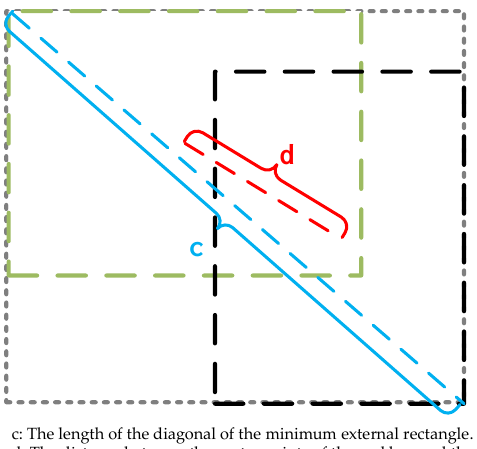
Figure 5. Diagram of CIoU.